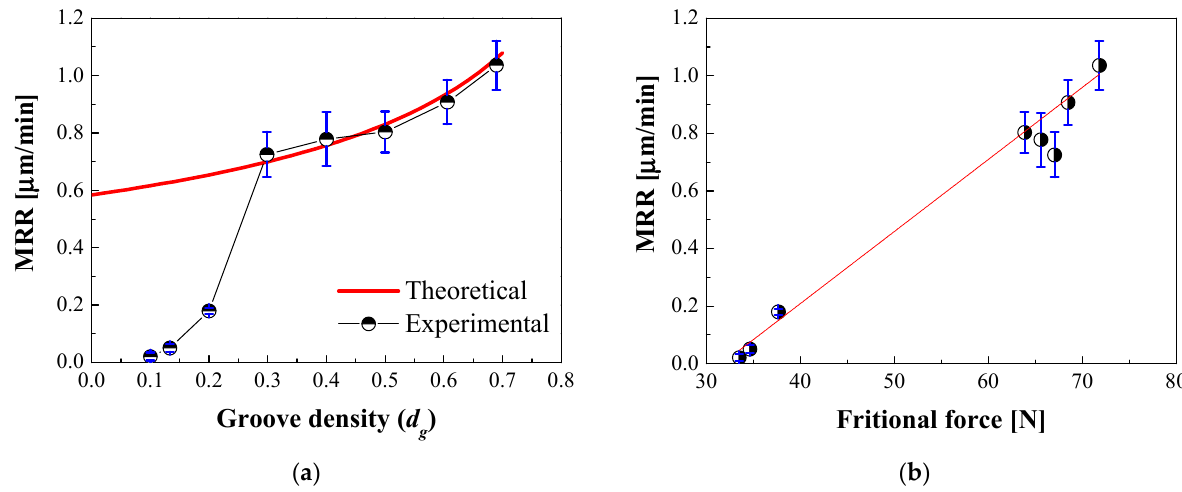
Figure 8. ( a ) Comparison of the theoretical material removal rate with the experimental results according to groove density; ( b ) relation between material removal rate and frictional